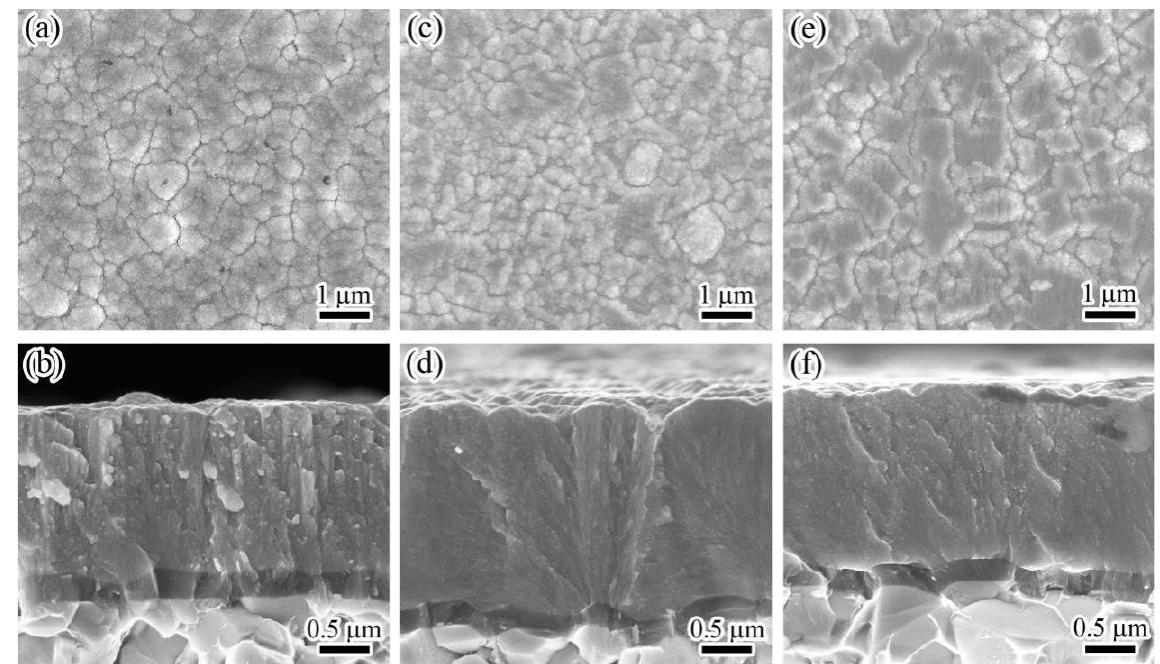
Figure 3. Surface and cross-sectional micrographs of the coatings at various charge voltages: ( a , b ) 650 V, ( c , d ) 700 V, and ( e , f ) 850 V.